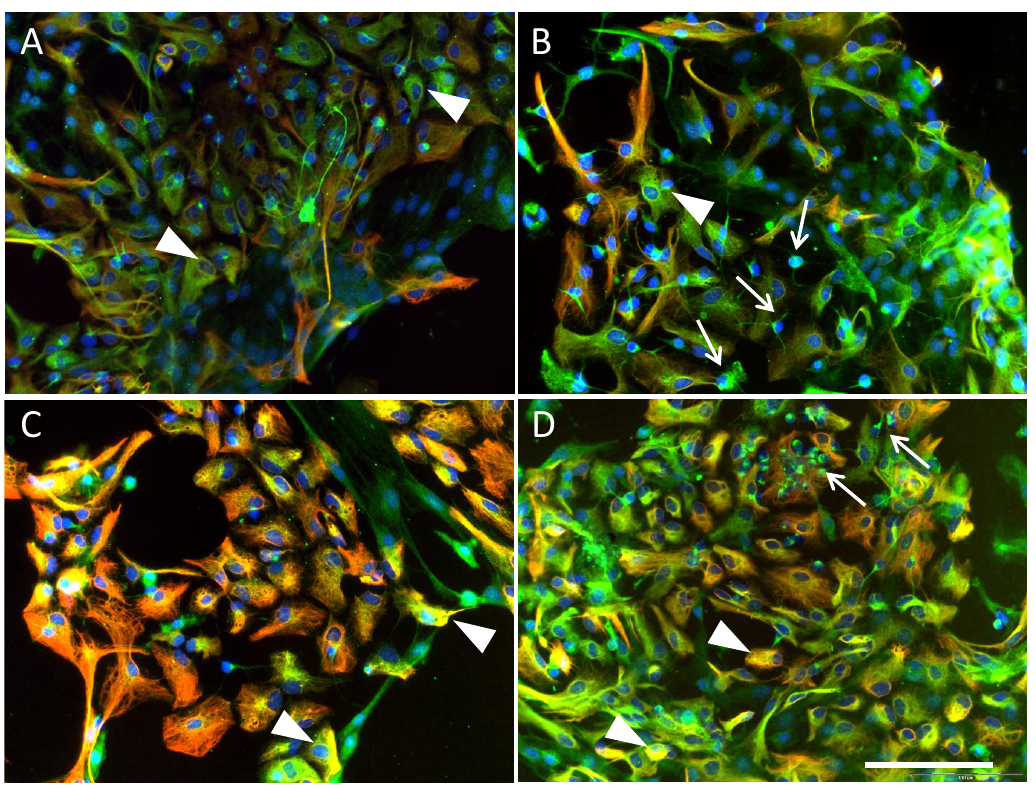
Figure 4. Expression of EPOR (green fluorescence) and GFAP (red fluorescence) in DIV7 neonatal rat astroglial primary culture. Cell nuclei are stained with DAPI (blue). ( A ) Normoxic control; ( B ) Cultures treated with BQ123 during normoxic conditions; ( C ) Hypoxic control; and ( D ) Cells treated with BQ123 during hypoxia. Arrows indicate the EPOR-positive bona fide neural precursors negative for GFAP; Arrowheads demonstrate the EPOR/GFAP-positive astrocytes. Scale bar in A – D 100